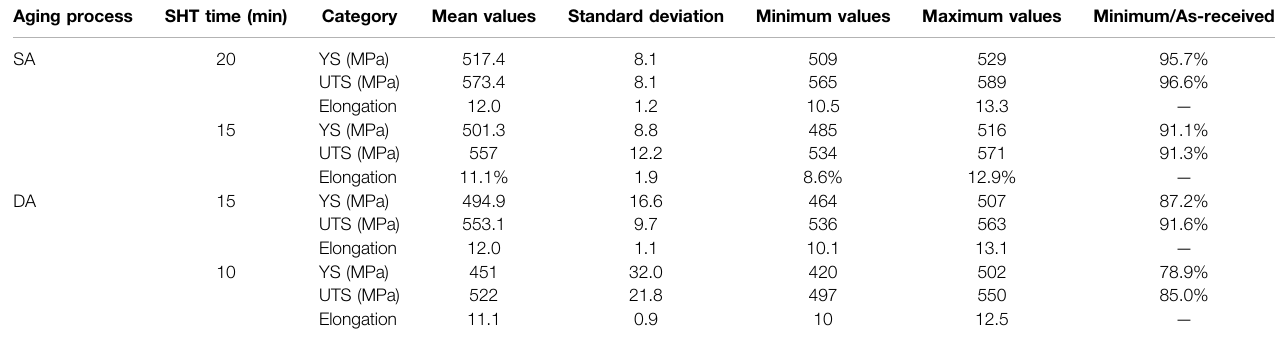
TABLE 2 | The statistical results of strength and elongation of samples under different process parameters. Aging process SHT time